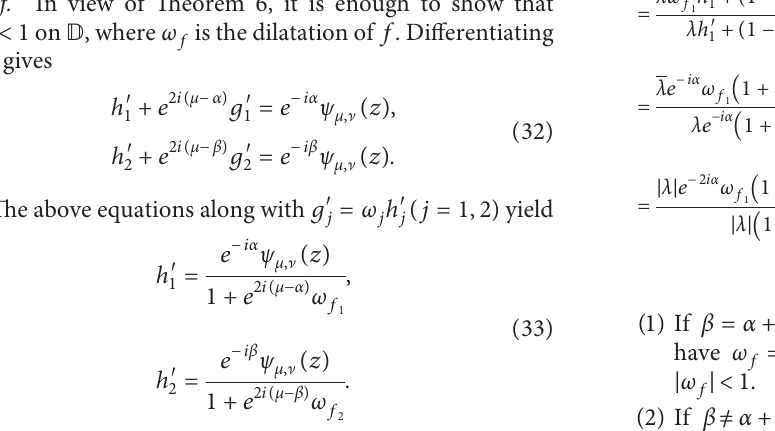
,f , and f . (a) f 1 2